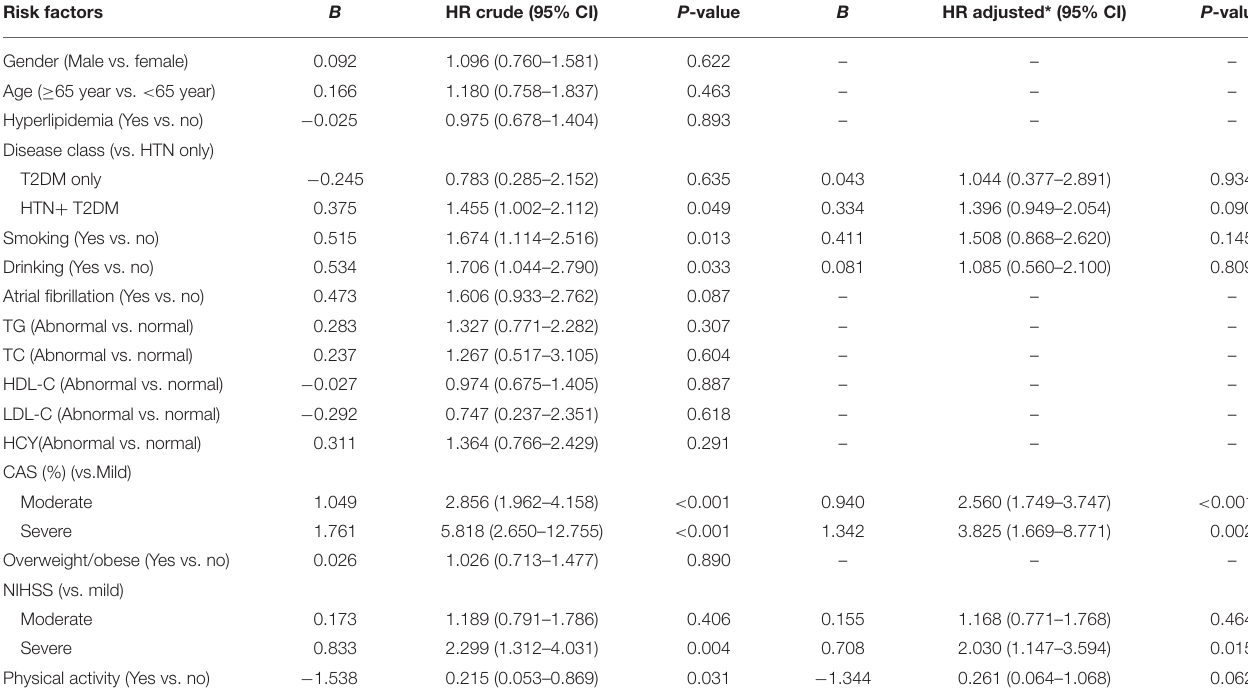
TABLE 6 | The influencing factors of stroke in T2DM and/or HTN patients with stroke